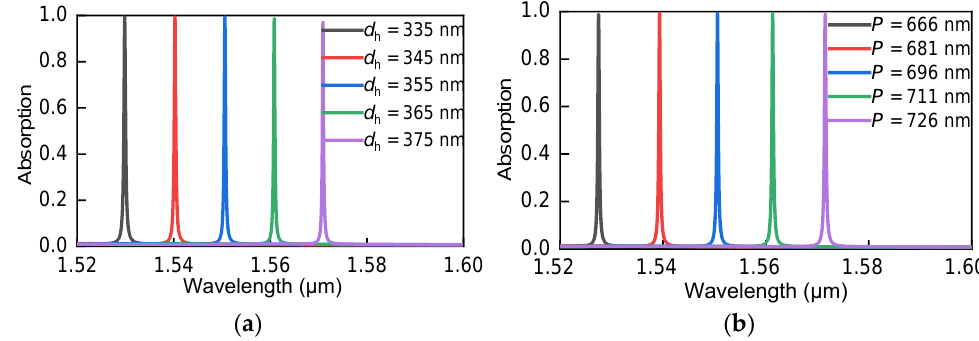
Figure 4. ( a ) Absorption spectra of the proposed structure with different waveguide layer thicknesses d h . ( b ) Absorption spectra of the proposed structure with different grating periods P .